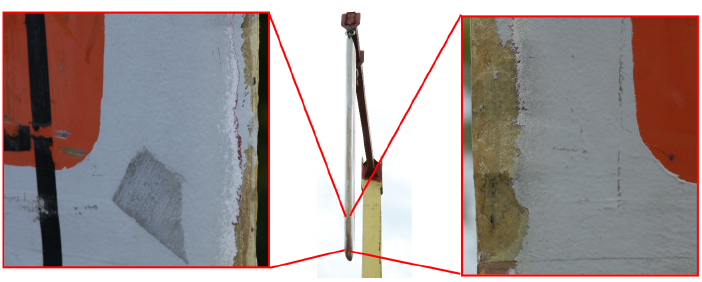
Figure 2. Testing blade together with the region chosen for reconstruction. The zoomed-in parts are of the two sides of the blade.